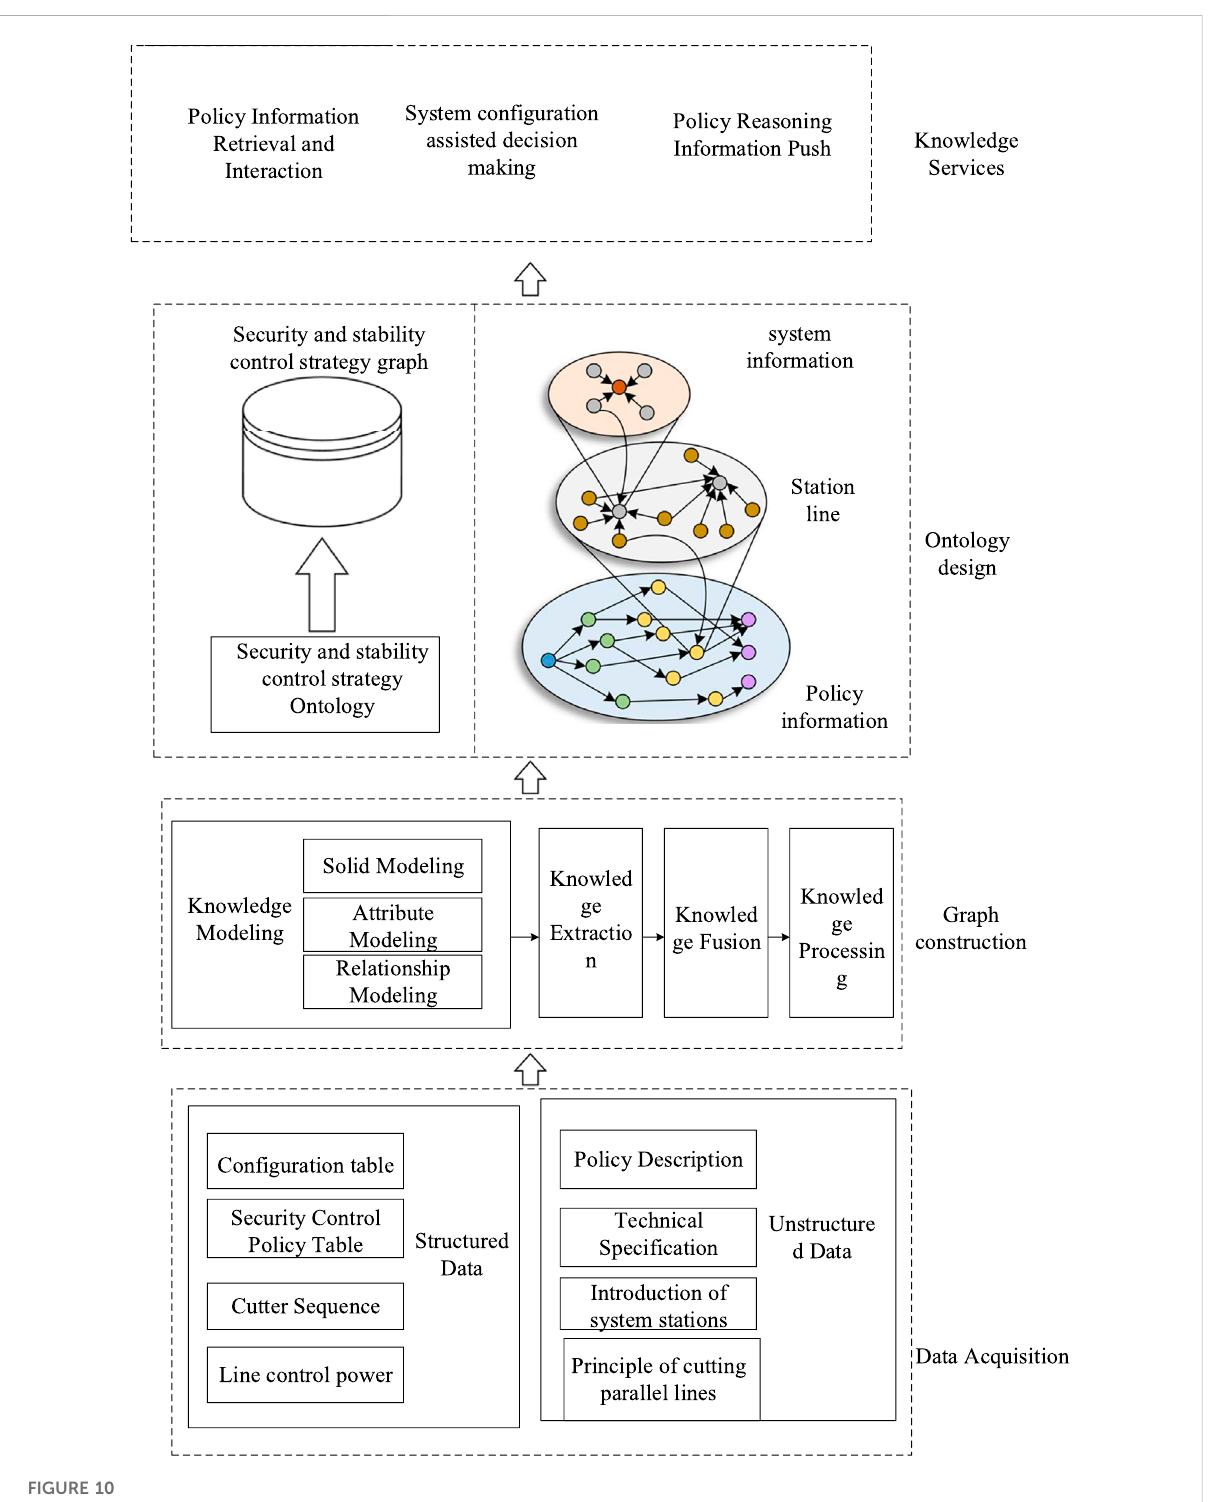
FIGURE 10 Security and stability control strategy knowledge graph construction